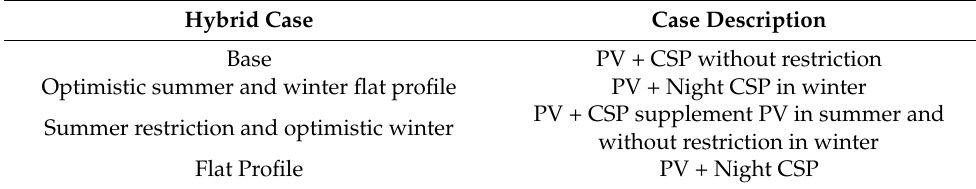
Table 5. Description of case studies.